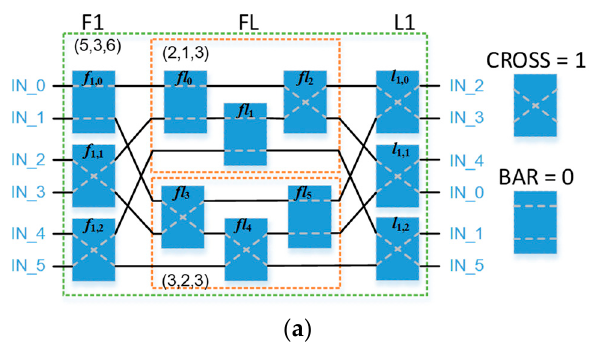
Figure 27. Flow chart of control signal generation of the switch in the switching network in the reconfigurable multimode LDPC decoder architecture.